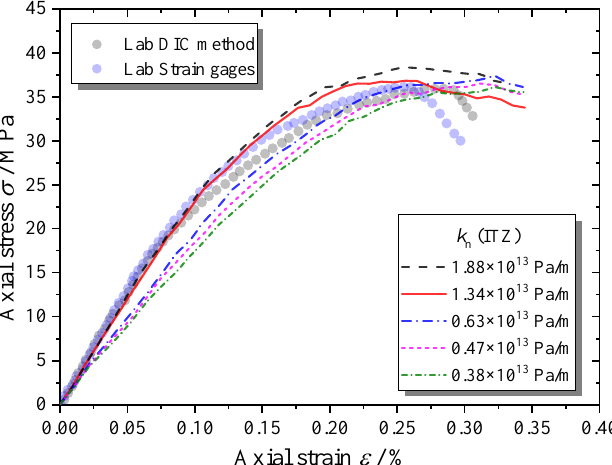
Figure 22. Complete compressive stress–strain curves of MRAC specimen with various ITZ stiffness